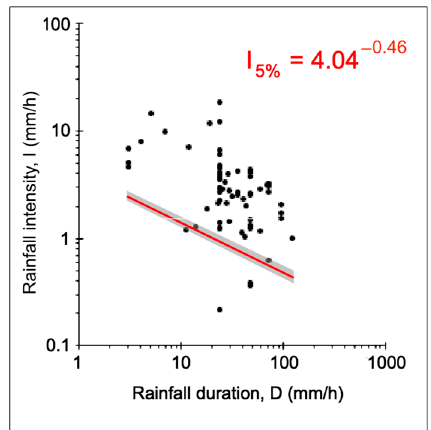
Figure 8. Rainfall thresholds obtained for the possible initiation of shallow landslides and mud/debris flows on the Portofino promontory corresponding to a 5% exceedance probability level (red curve) and associated uncertainty (grey pattern).